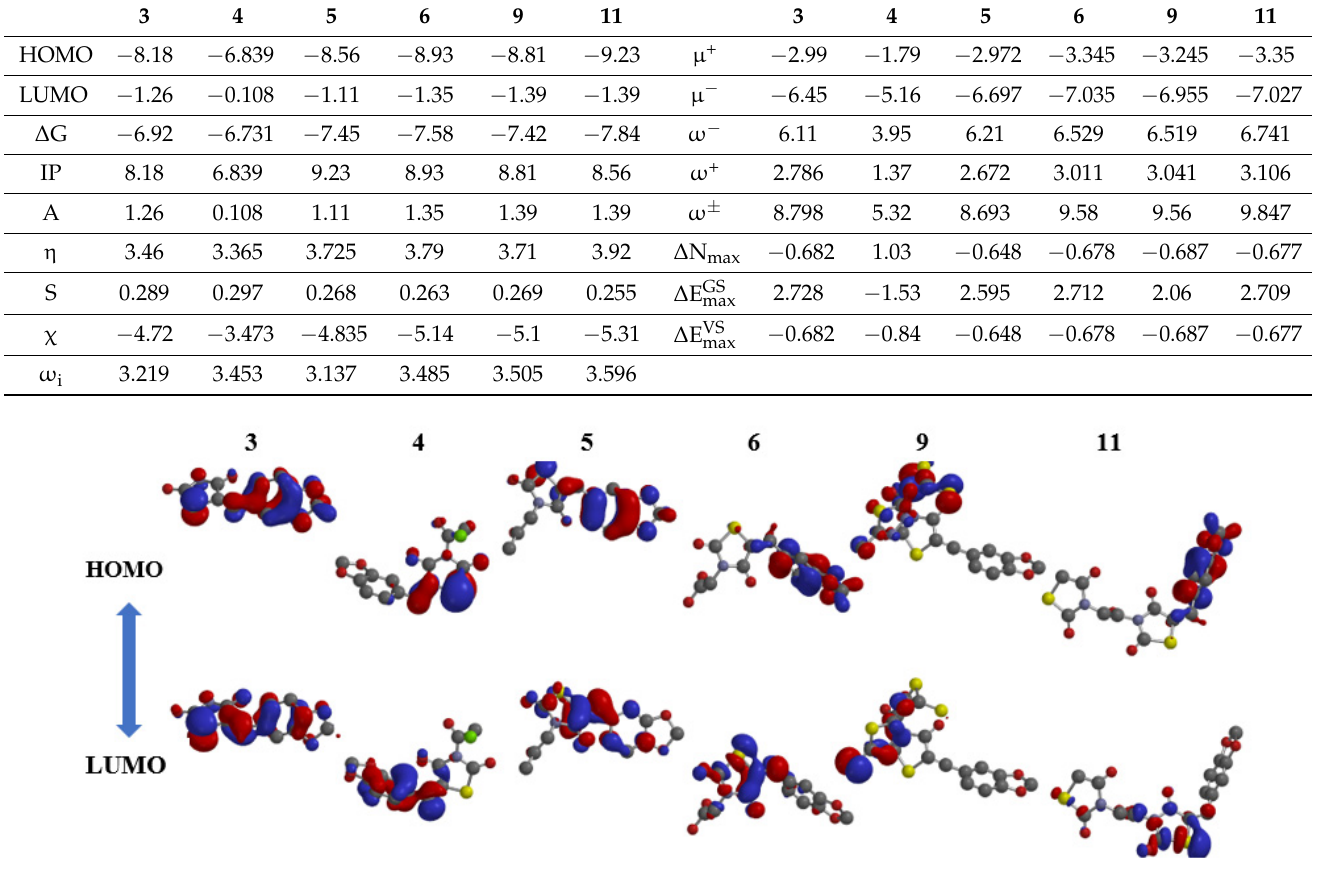
Figure 2. HOMO and LUMO density of compounds (3,5–12) .